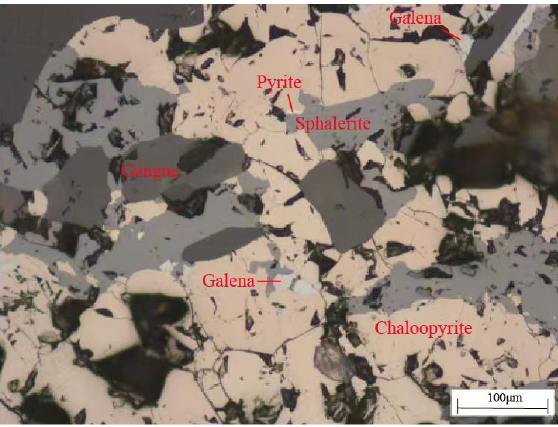
Figure 2. XRD pattern of the ore.